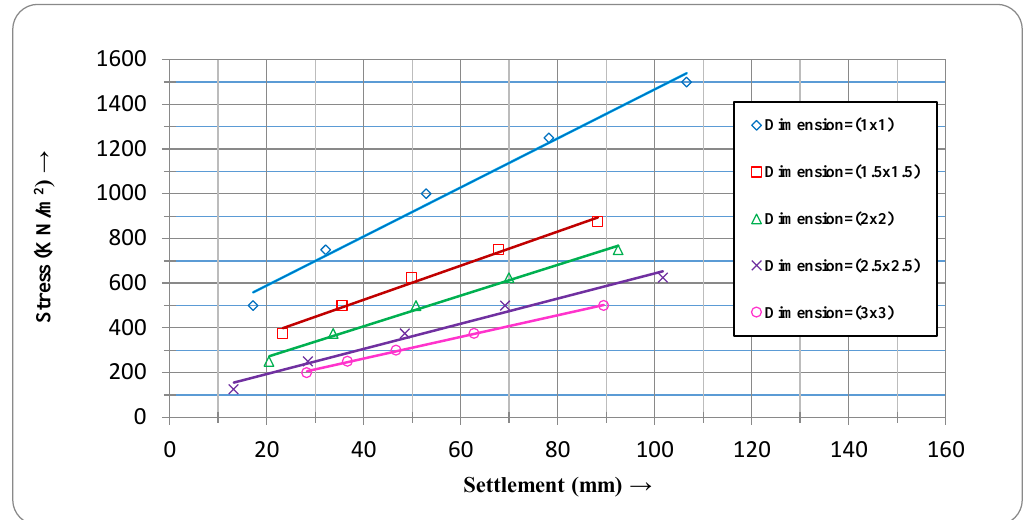
Fig. 17. Stress vs. Settlement graph for different footing sizes (spacing 1.5 m fixed between two adjacent footings). Regression analysis of Stress vs Settlement (spacing 1.5 m fixed between two adjacent footings). Footing Dimension (m 2